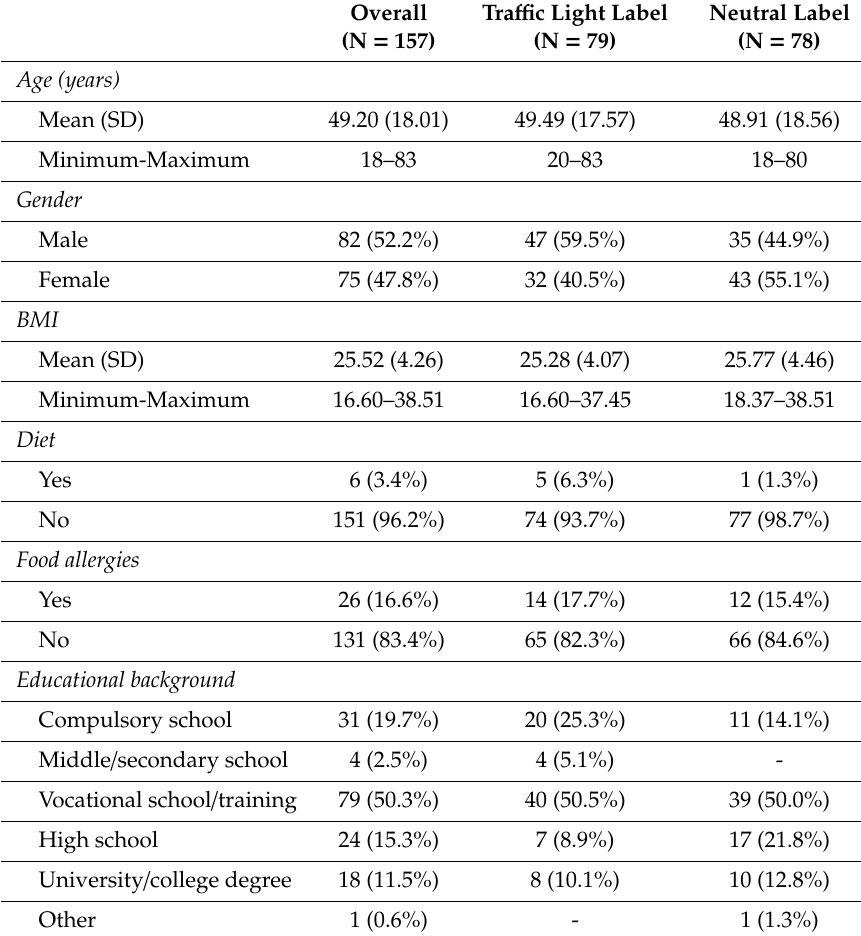
Table 1. Descriptive sample statistics in separate